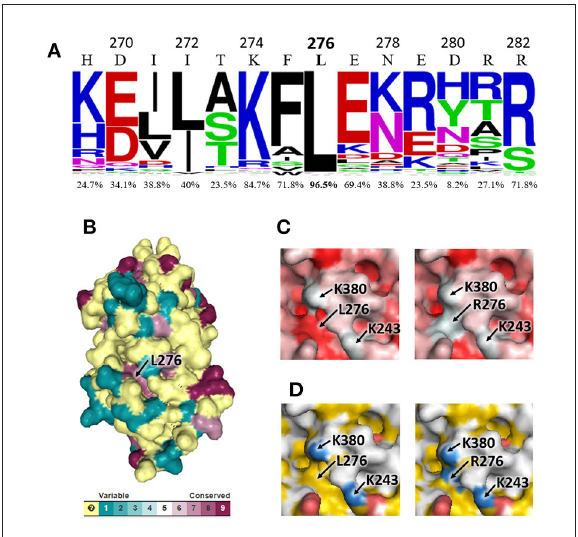
FIGURE2 Bioinformatic analysis of the impact of L276R variant on human AAT. (A) WebLogo representation of the alignment region that contains the L276 residue. Numbers above each amino acid symbol indicate positions in mature human AAT, while percentages indicate the conservation level of the residues present in human AAT. (B) 3D model of AAT obtained with Consurf server from the multiple alignment of AAT sequences. Different colors represent conservation scores. (C,D) Structural details of the cavity where L276R substitutions occurs, visualized with PyMOL. Two positive charged lysine residues (K380 and K243) are also indicated. Different colors represent different chemical properties of amino acids, ranging from hydrophilic (white) to hydrophobic (red) in (C) and from positive-charged (blue) to neutral (yellow) and negative-charged (red) in (D)